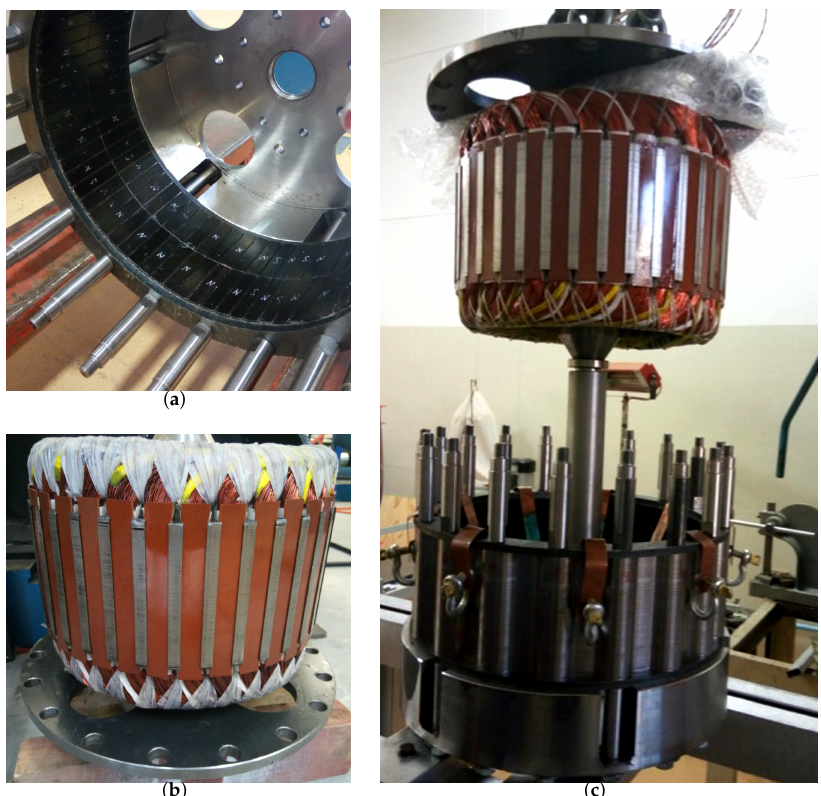
Figure 24. Machine construction: ( a ) all sets of PMs are mounted onto the rotor core, ( b ) side view of wound stator with distributed overlapping windings, and ( c ) assembling of the PMVM prototype.